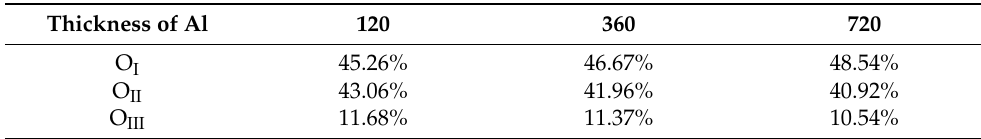
Table 4. Areas of O 1s peaks of ZnO nanoflower arrays as a function of thickness of the Al sacrifi- cial